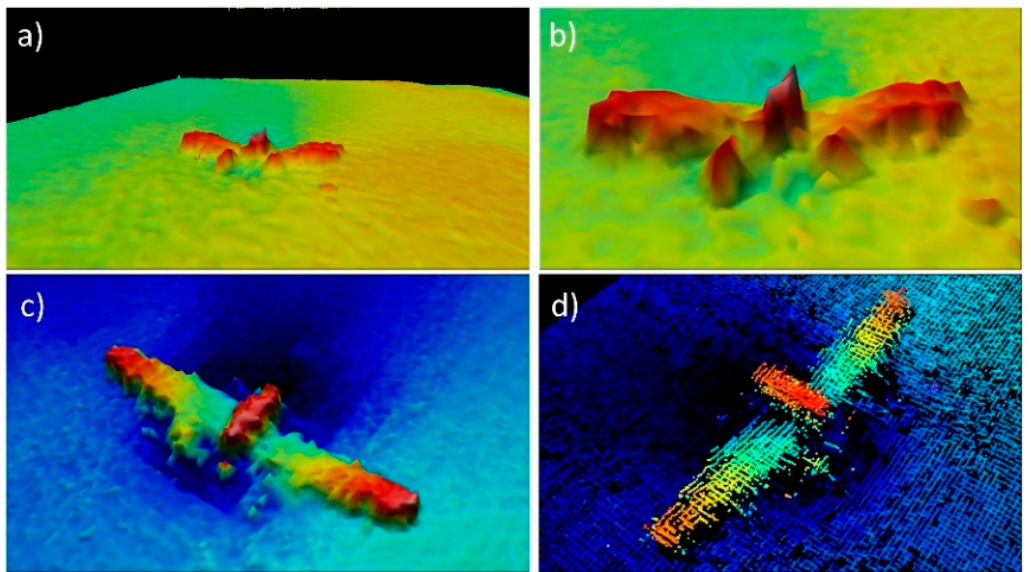
Figure 6. Digital models of the plane wreck: ( a , b ) models developed based on data recorded during one pass over the wreck; ( c , d ) models developed based on the increased density of bathymetric data.